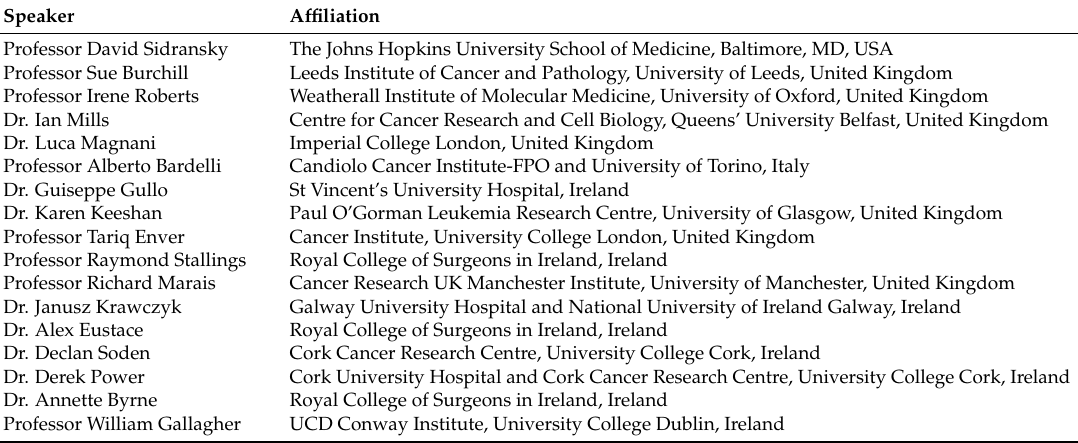
Table A1. Conference Speaker